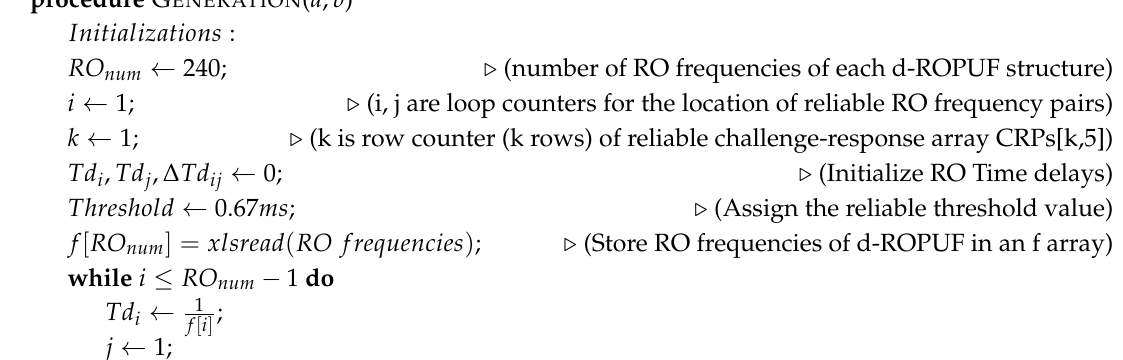
Algorithm 1 OTD algorithm step1: Reliable CRPs generation procedure G ENERATION ( a , b